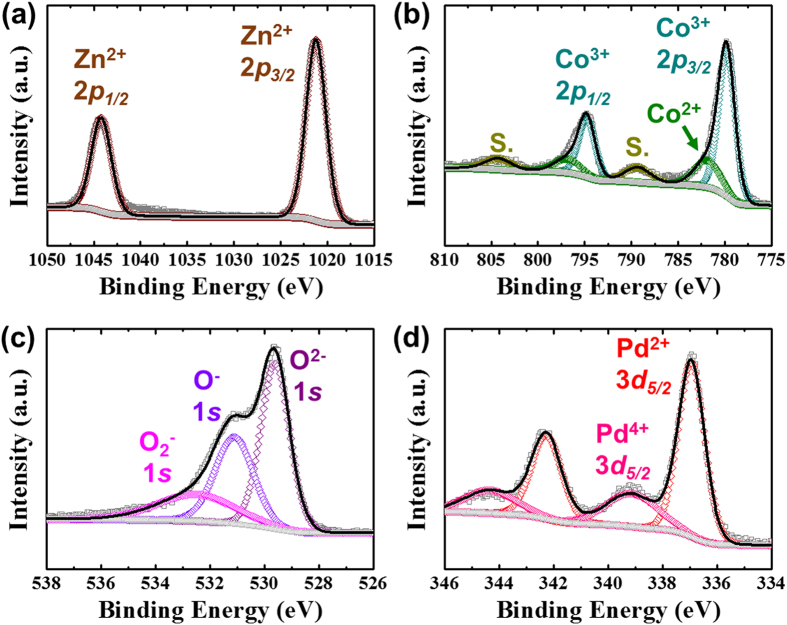
XPS analysis using high resolution spectrum of Pd-ZnO/ZnCo2O4 HSs in the vicinity of (a) Zn 2p, (b) Co 2p, (c) O 1 s, and (d) Pd 3d.